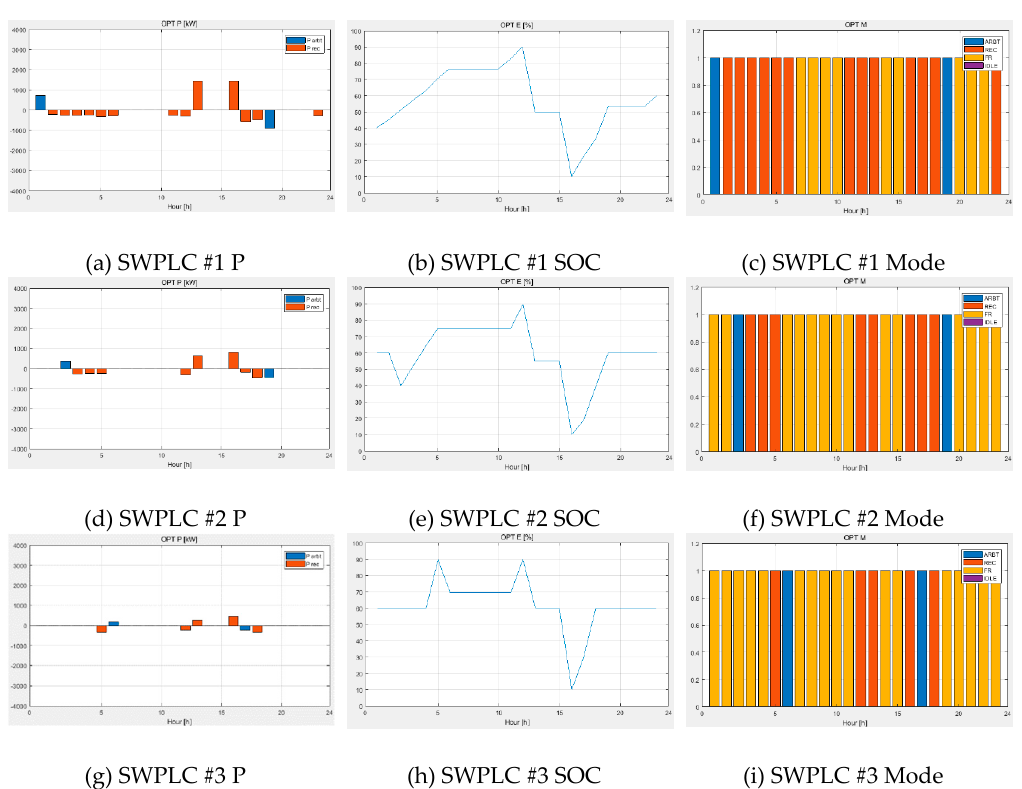
Figure 6. Scenario 3 simulation results.